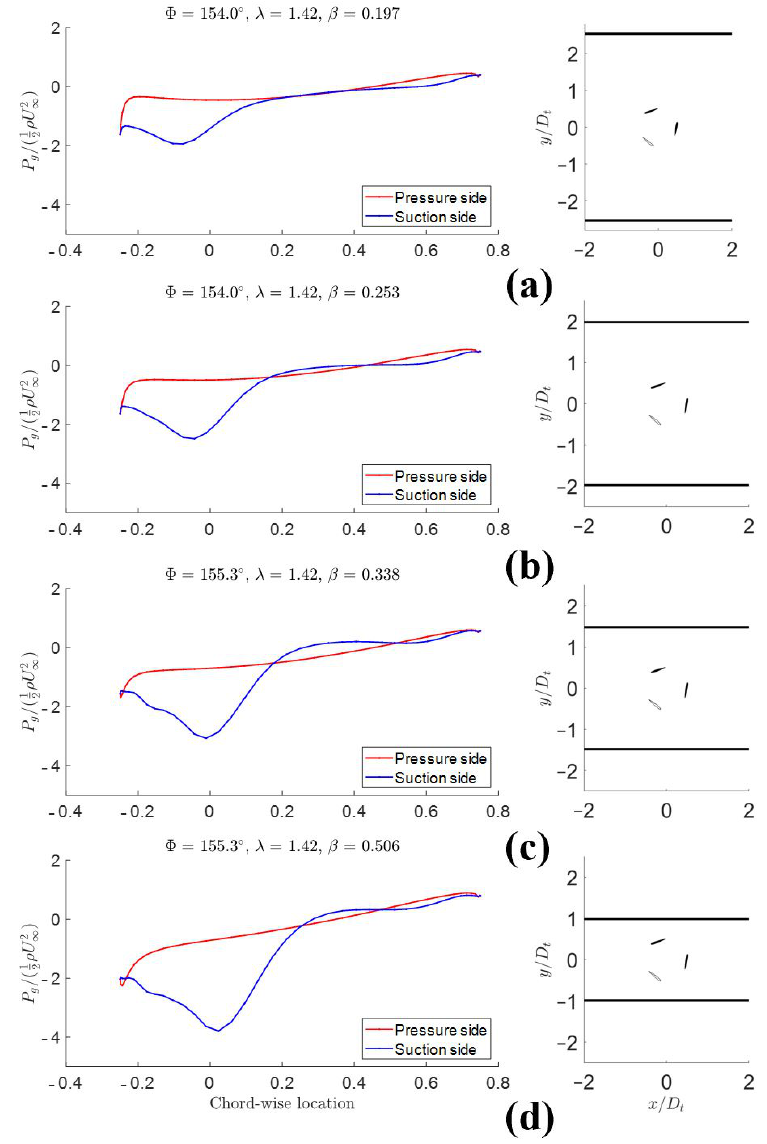
Figure 12. The pressure loading on one of the turbine blades after reaching its maximum torque angle of 4 blockage ratios: 19.7% ( a ), 25.3% ( b ), 33.8% ( c ), and 50.6% ( d ). The relevant blade is colored in white on the right